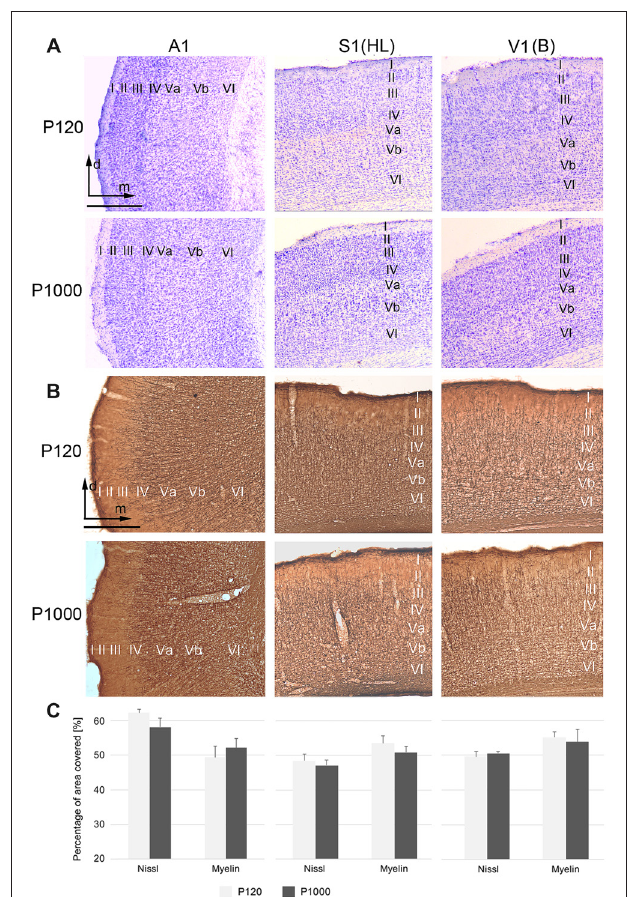
FIGURE 1 | The general cyto- and myeloarchitectural patterns of the primary sensory cortices do not change over age. (A,B) Frontal sections showing the cytoarchitecture (Nissl; A ) and myeloarchitecture (MBP; B ) of the primary auditory (A1), somatosensory (S1, hindlimb area HL), and visual cortex (V1, binocular subfield B) cortex in adult (P120) and elderly animals (P1000). Scale bars: 500 µ m. I–VI, cortical layers I–VI; d, dorsal; m, medial. (C) Percental area of A1 (right), S1 (middle), and V1 (left) covered by neuronal elements, i.e., by neuronal somata (Nissl) or myelinated fibers (myelin MBP). Values are percentages ± 1 SEM, n = 9 sections per